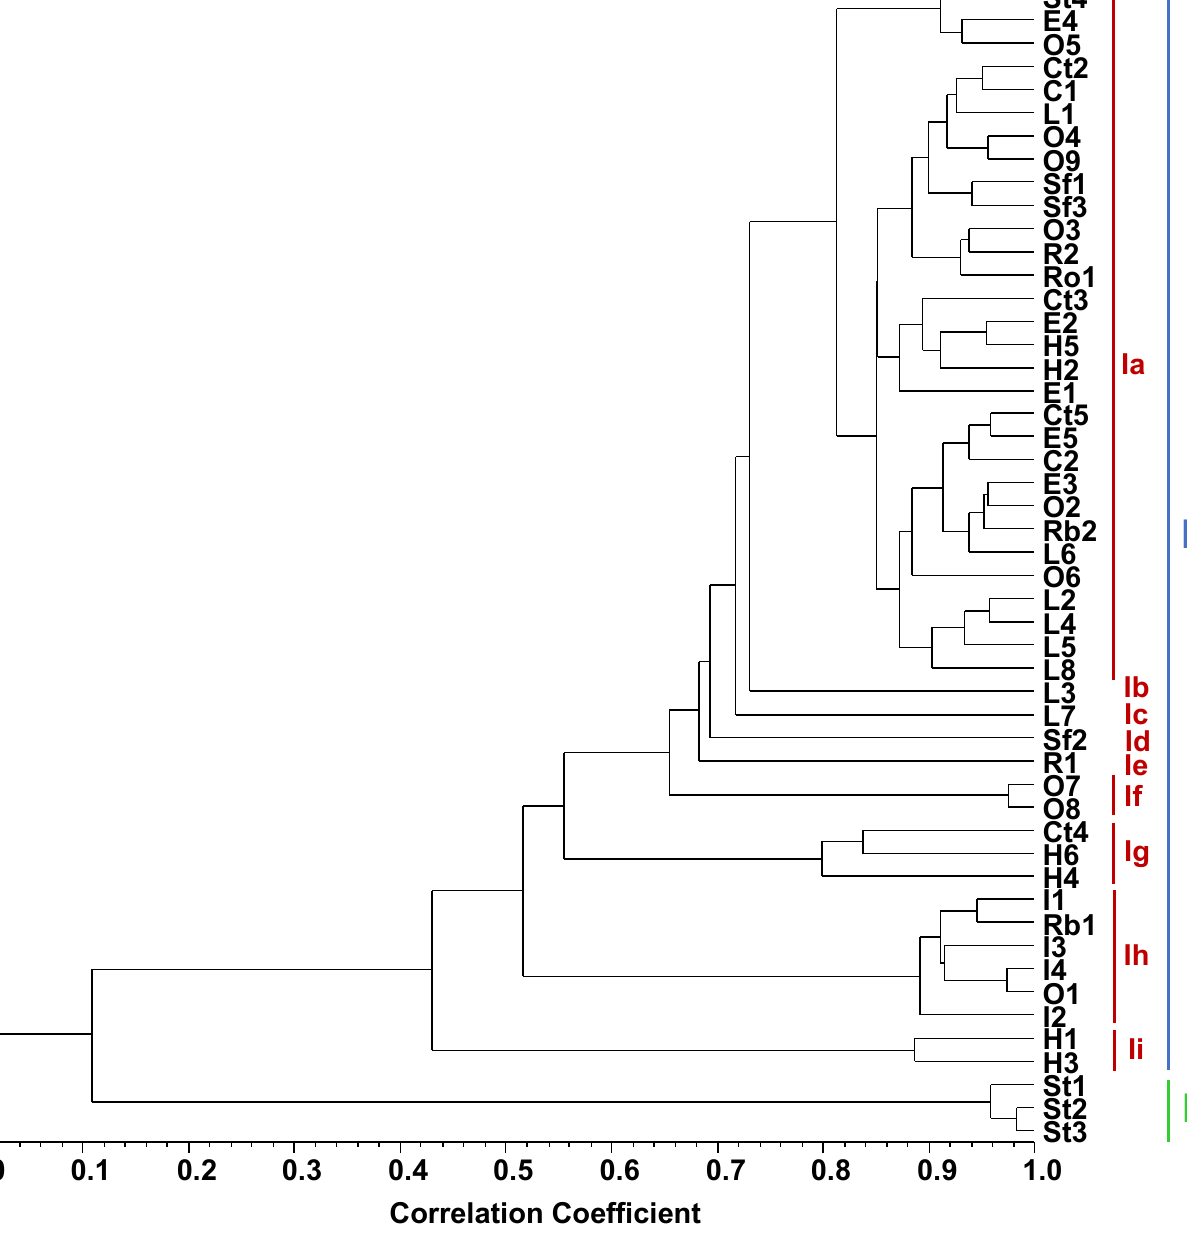
Figure 2. Dendrogram obtained by cluster analysis of the percentage composition of volatile compounds isolated by hydrodistillation from the 51 honey samples, based on correlation, and using the unweighted pair-group method with arithmetic average (UPGMA). Ct: carob tree; C: chestnut; E: eucalyptus; H: bell heather; I: incense; L: lavender; O: orange; R: rape; Rb: raspberry; Ro: rosemary; Sf: sunflower; St: strawberry tree.